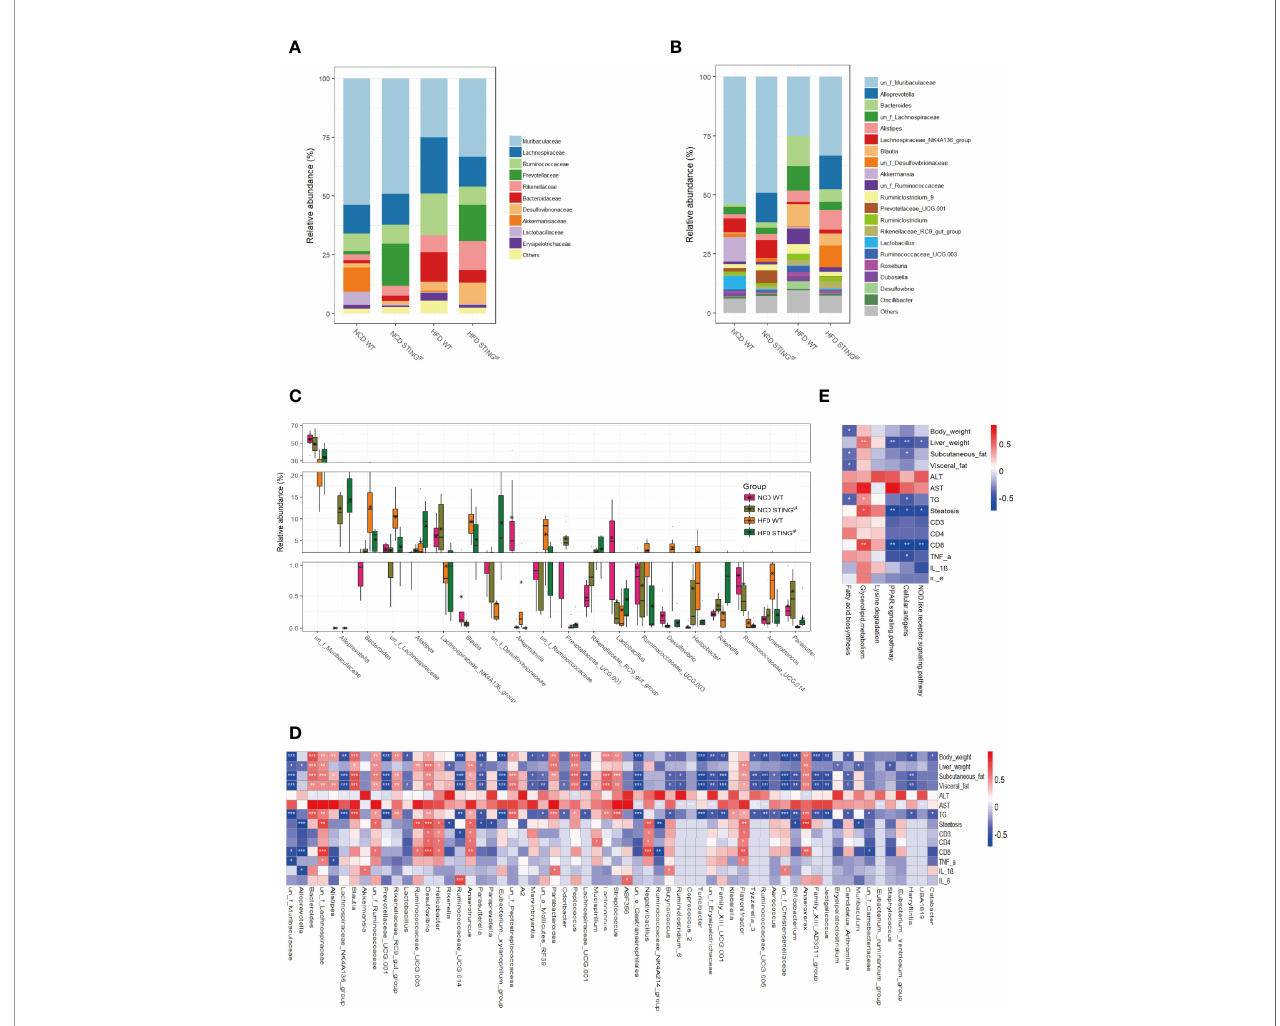
FIGURE 5 | STING de fi ciency leads to the alteration of gut microbiota components and metabolic phenotype-related pathway in mice. (A, B) Bar charts represent the relative abundance of bacterial families and genus in all mice according to their diet and genotype. (C) The relative abundance of different species in the gut microbiota at the genus level of WT and STING gt mice under different diets (Top 20). (D) Correlation analysis of the phenotype of NAFLD and gut microbiota at the genus level. (E) Correlation analysis of differential metabolic pathways associated with NAFLD development and metabolic phenotype. *p < 0.05, **p < 0.01, ***p < 0.001 (unpaired t-test or